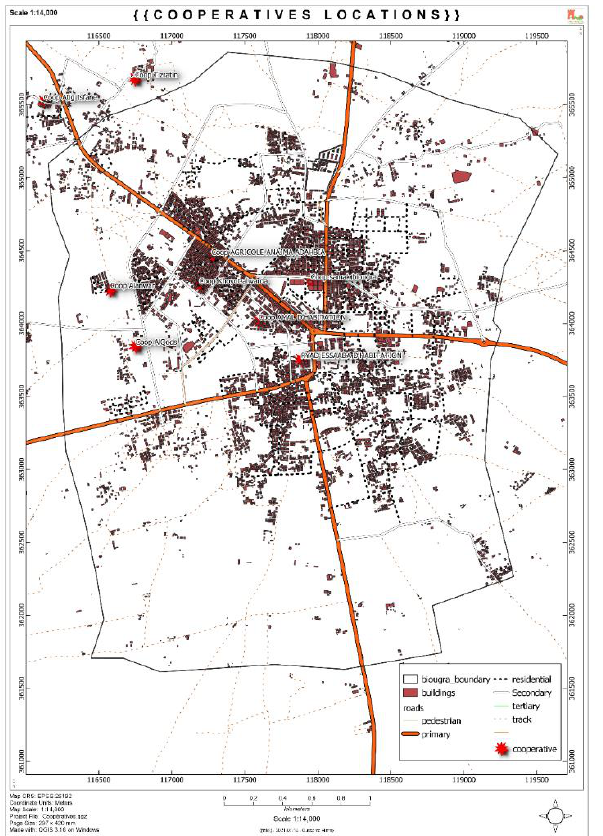
Figure 12 . Cooperatives location in the city of Biougra